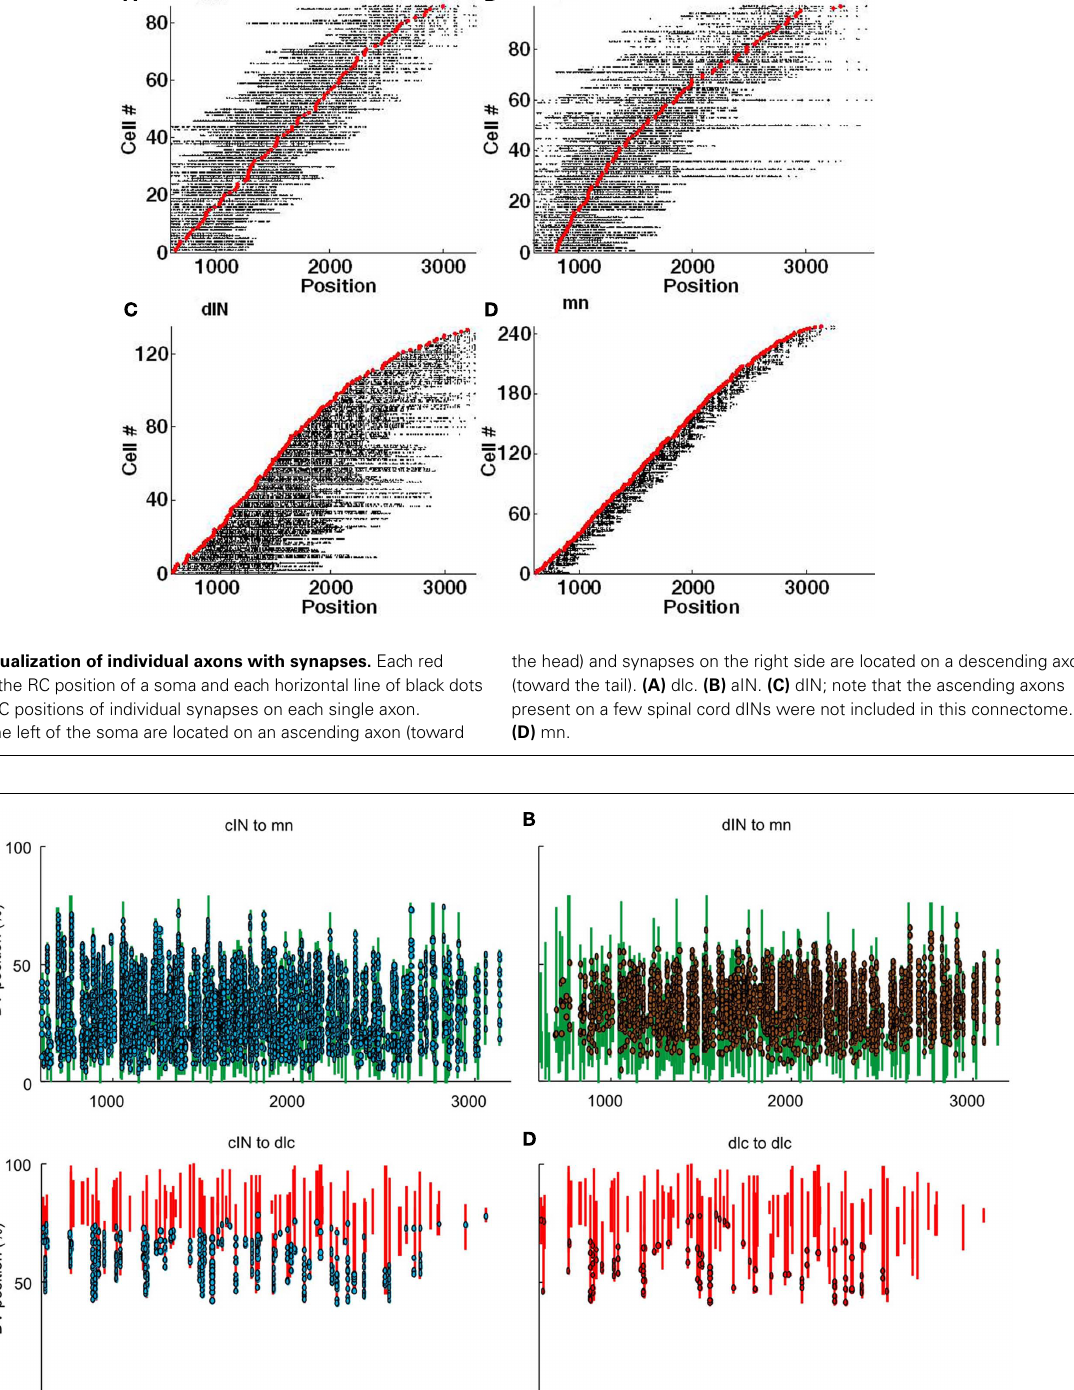
FIGURE 6 |Visualization of individual dendrites with synapses. Each vertical line of the figure corresponds to an individual dendrite. Dots indicate the DV positions of individual synapses. Dendrites and